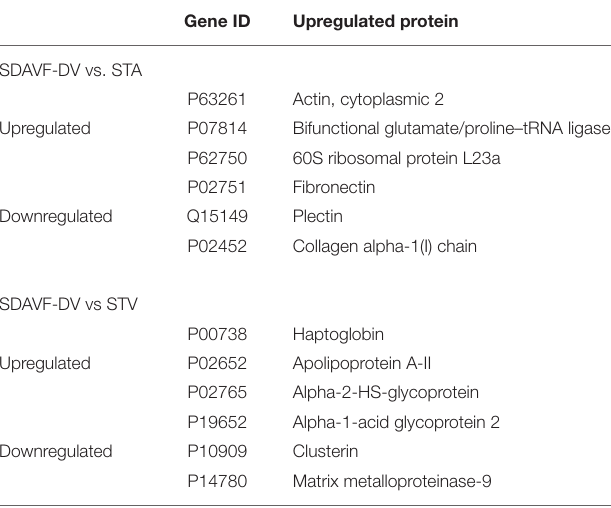
TABLE 3 | Top three interaction protein number